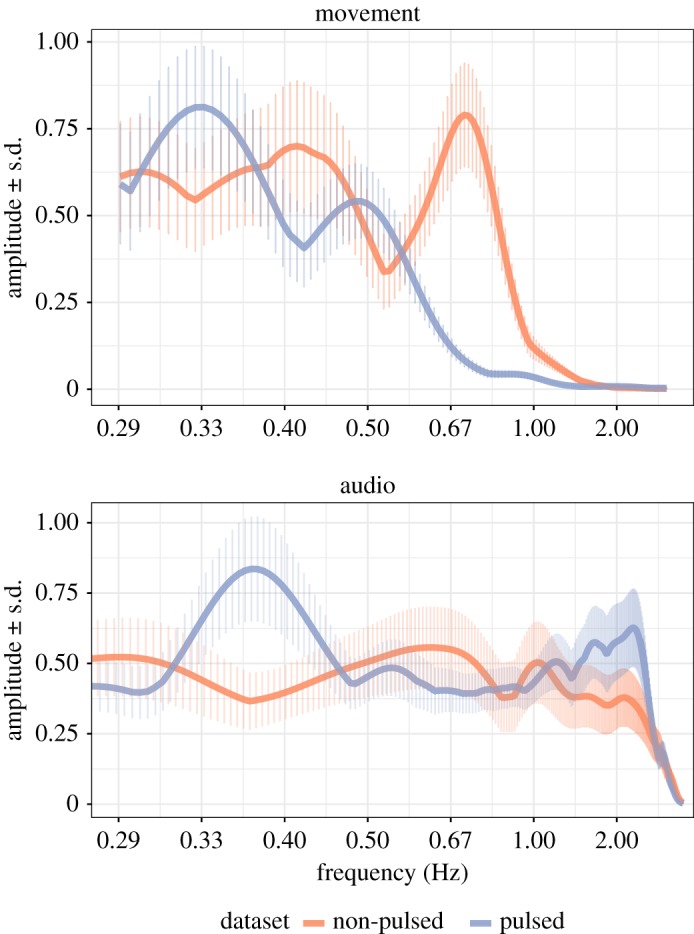
Wavelet amplitudes (means and standard deviations) for movement and audio aggregated across all performers.